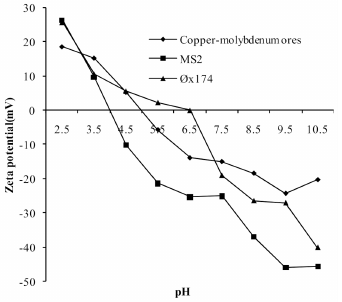
Figure 5. Zeta potential of viruses and copper–molybdenum (Cu–Mo)